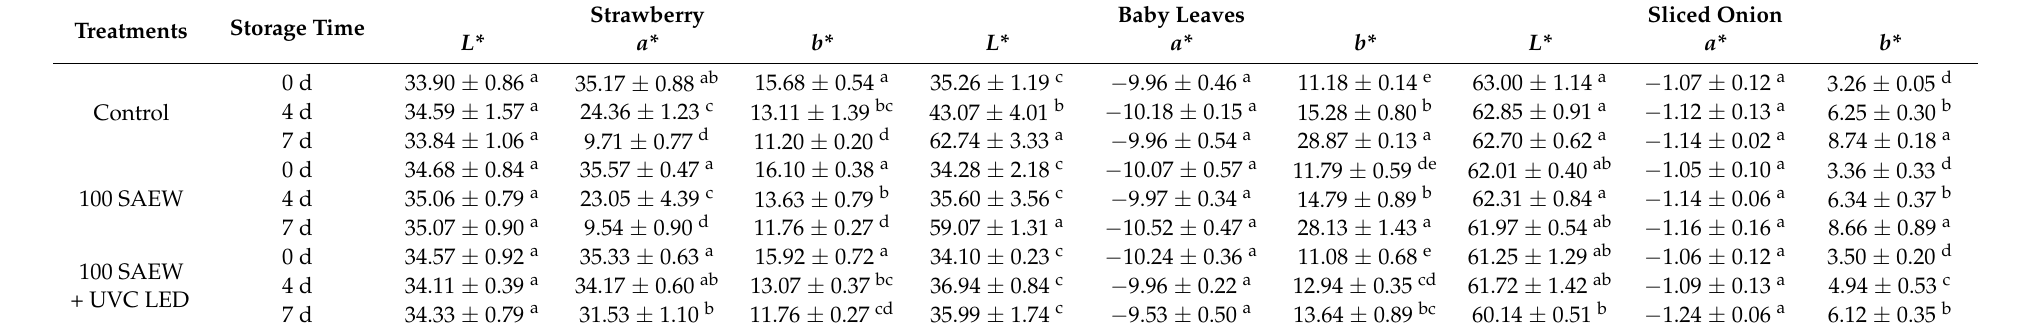
Table 1. Effect of combined treatment on L* , a* , b* values in soft fresh produce during 7 days of storage at 10 ◦ C. Treatments